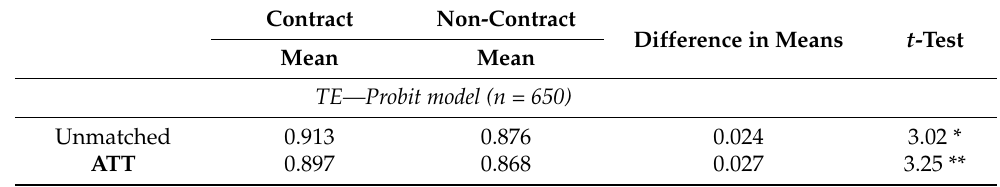
Table 7. Mean and standard deviation of technical efficiency in PSM matching estimations.